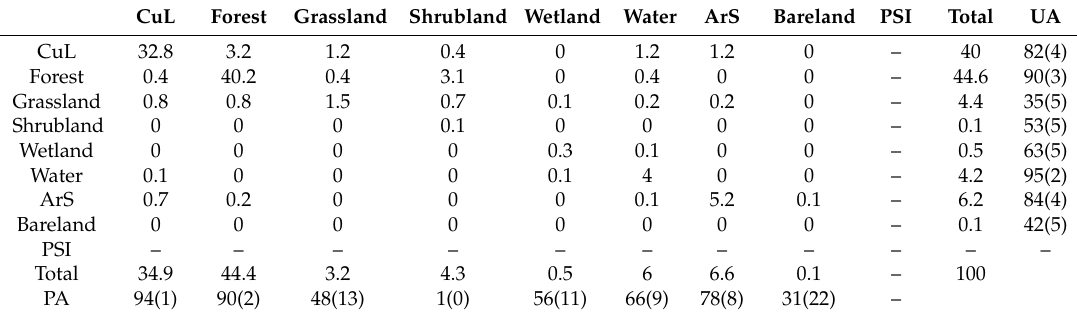
Table A9. The error matrix of estimated area proportions for R9: Overall accuracy is 84.0% (2.1%).